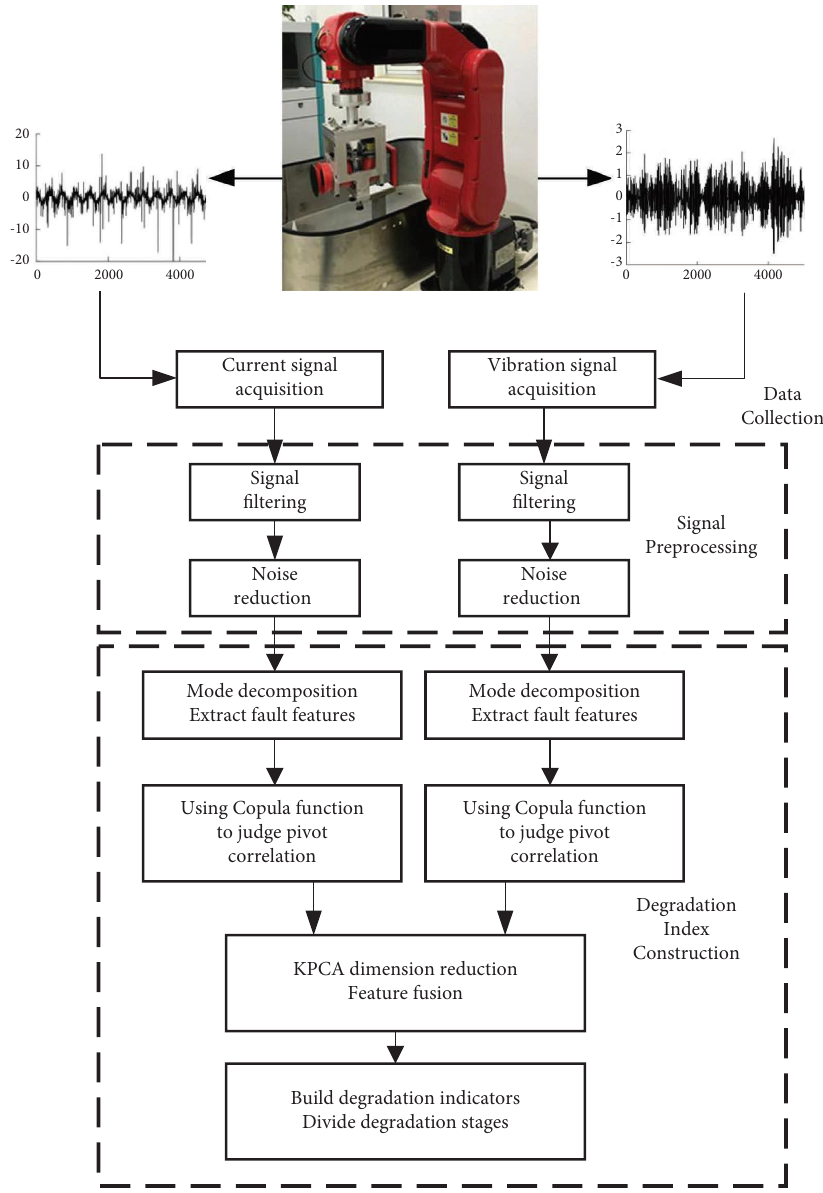
Figure 2: Construction of health